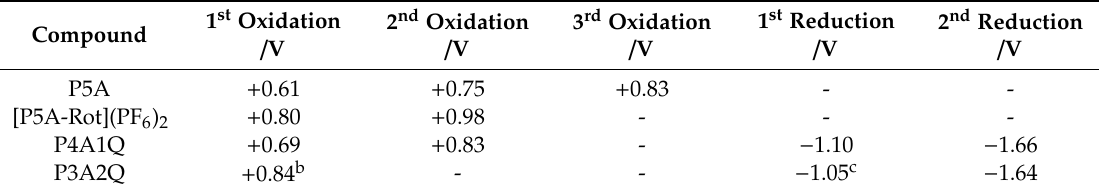
Table 4. Square Wave Voltammetric data a